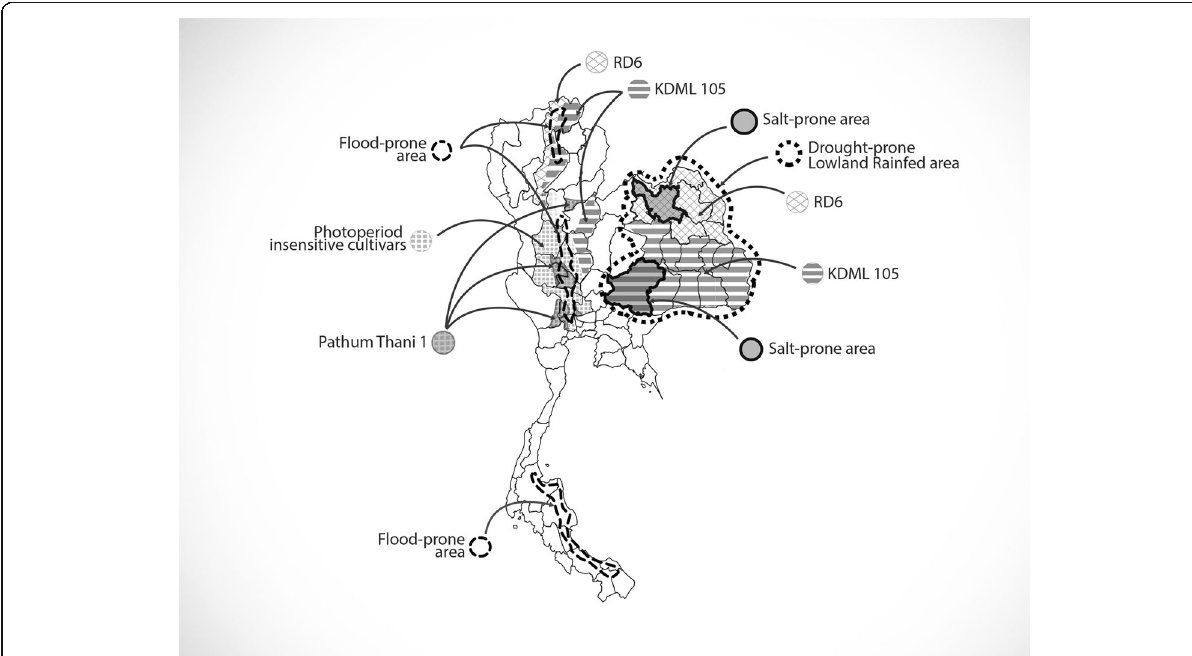
Fig. 1 Geographical distribution of Thai Hom Mali rice, RD6, photoperiod insensitive aromatic and non-aromatic rice cultivars, in relation to abiotic stresses drought, salinity, and flooding, in the lowland rainfed area in